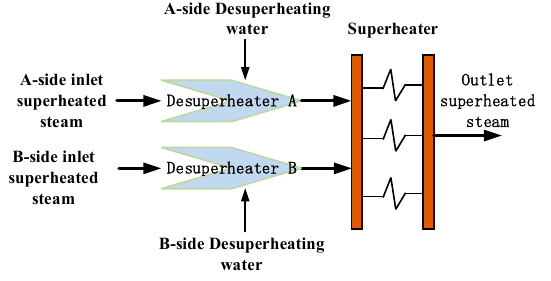
Figure 4. Superheated-steam thermal process.